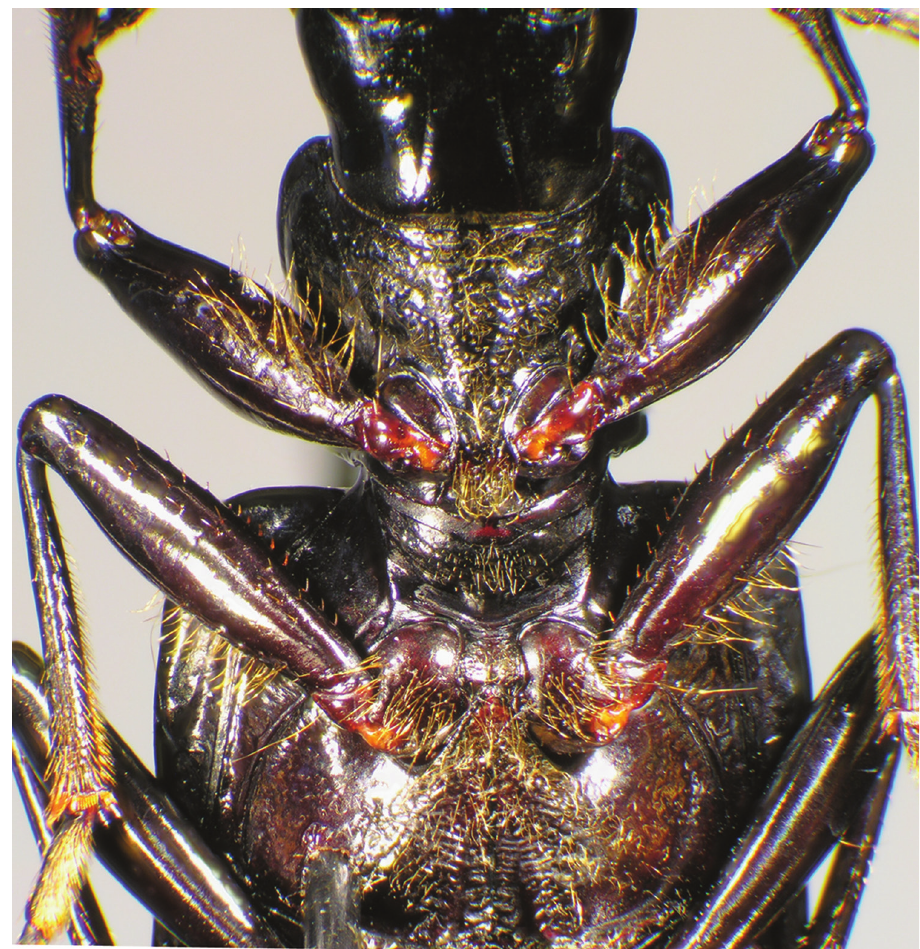
Figure 31. Digital image of the upper ventral surface and associated seta pattern of Catascopus ( Catasco- poides ) horni